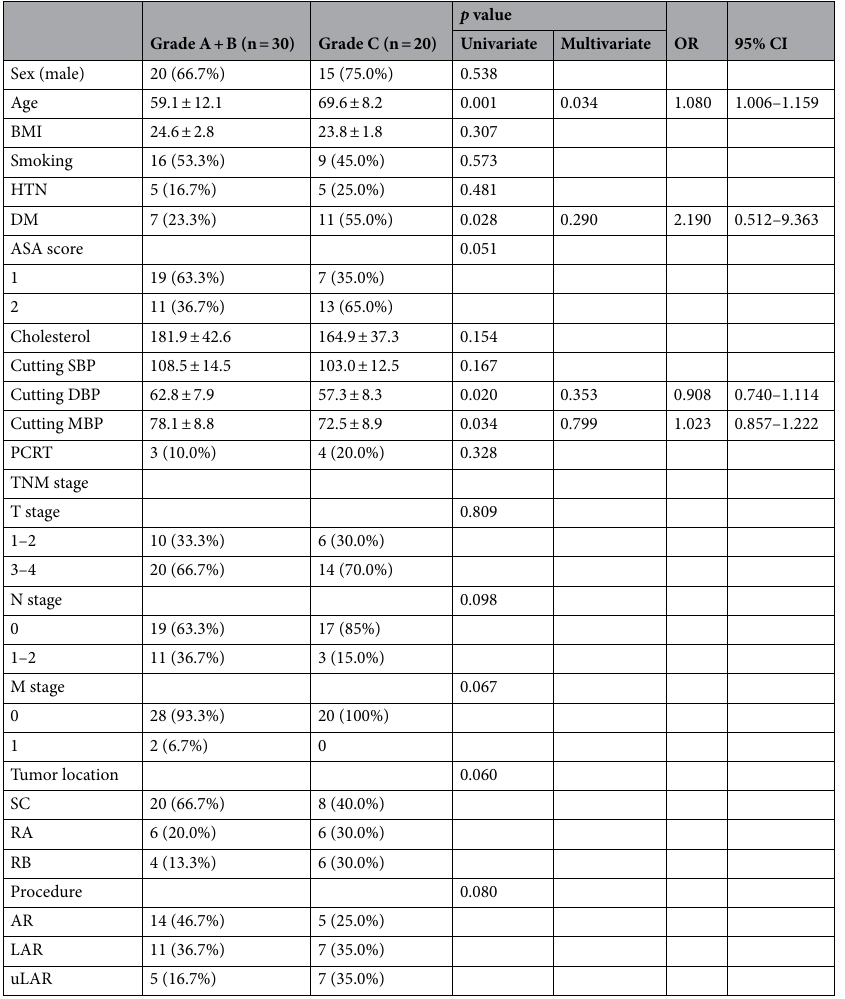
Table 5. Patient factors associated with perfusion according to grade (A + B vs. C). OR odds ratios, CI confidential interval, BMI body mass index, HTN hypertension, DM diabetes mellitus, SBP Systolic blood